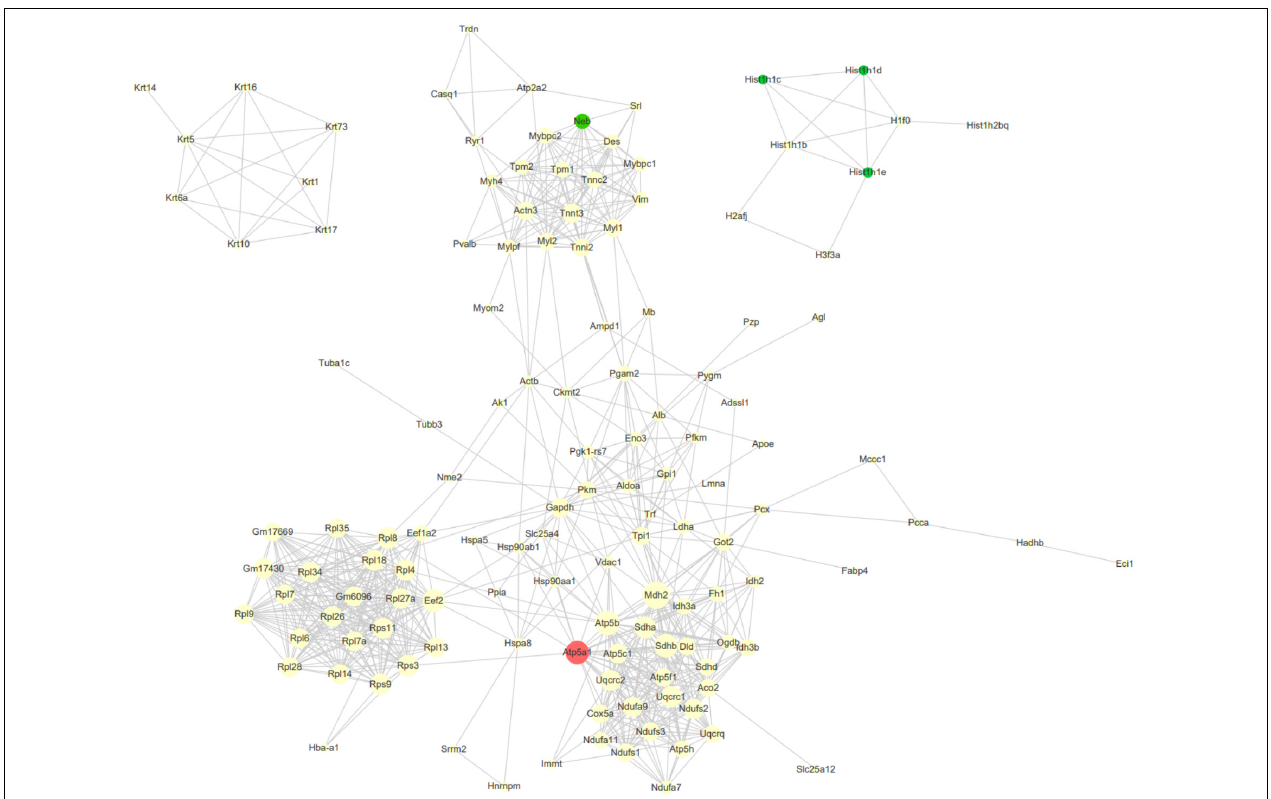
FIGURE 8 | Protein-protein interaction (PPI) network analysis of DEPs. Network analysis using CytoScape of the MSC proteins interactome reveals clustering around nodes involved in apoptosis, metabolism and structural maintenance. The degree of a node indicates the number of connections to other nodes, edge thickness indicates the degree of interactions. The red nodes indicated consistently upregulation DEGs at four time points, and the green nodes indicated consistently downregulation